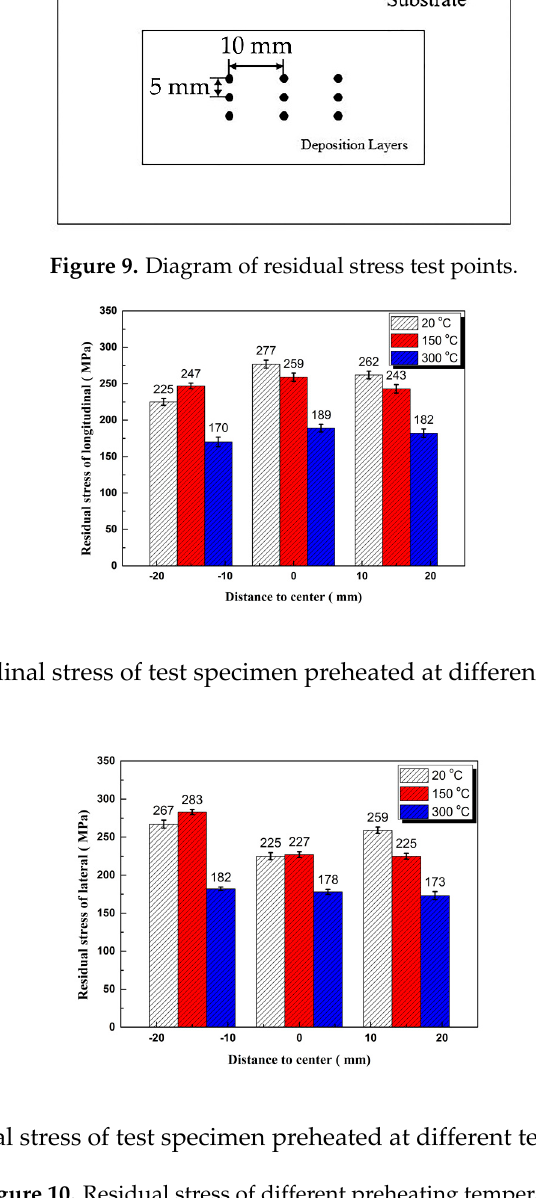
Figure 10. Residual stress of different preheating temperature.